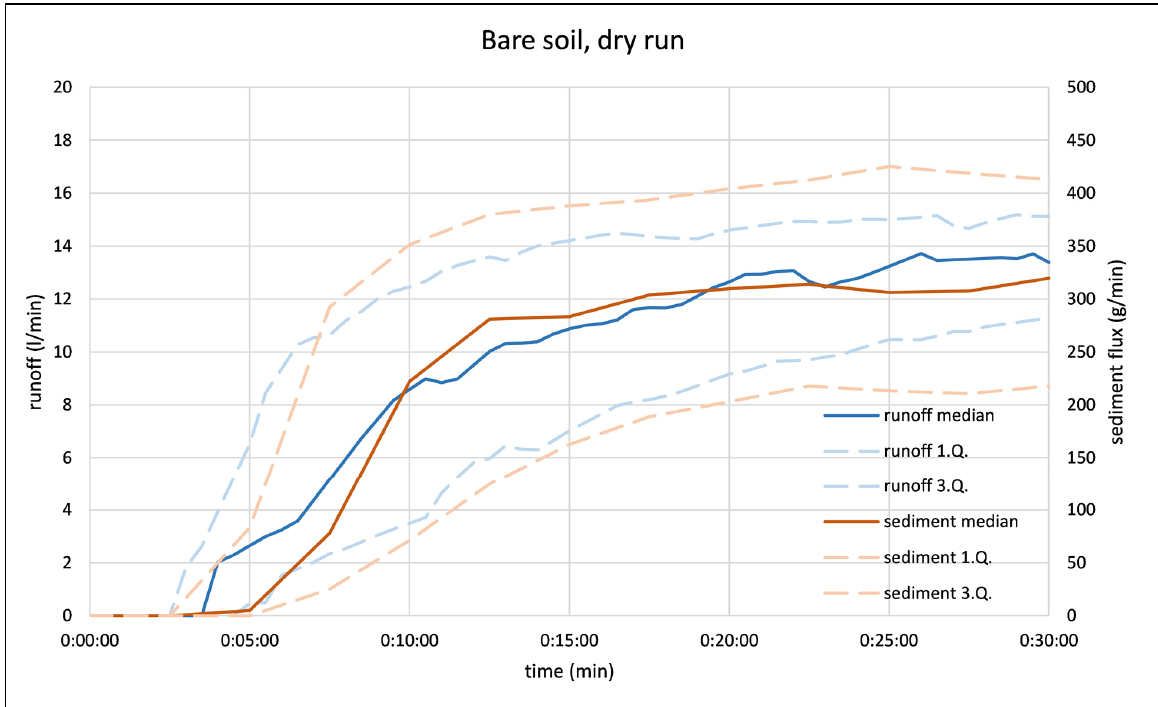
Figure 2. Box plot of 71 experiments in dry and wet soil conditions. Table 3. Box plot data.